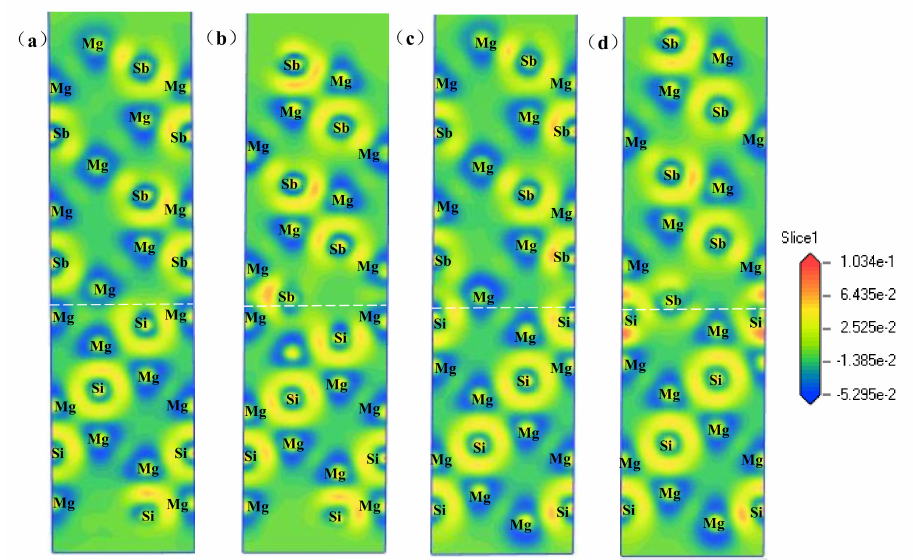
Figure 8. Charge density di ff erences (e / A 3 ) after full relaxation for the ( a ) Mg-HCP-Mg interface, ( b ) Mg-HCP-Sb interface, ( c ) Si-HCP-Mg interface, and ( d ) Si-HCP-Sb